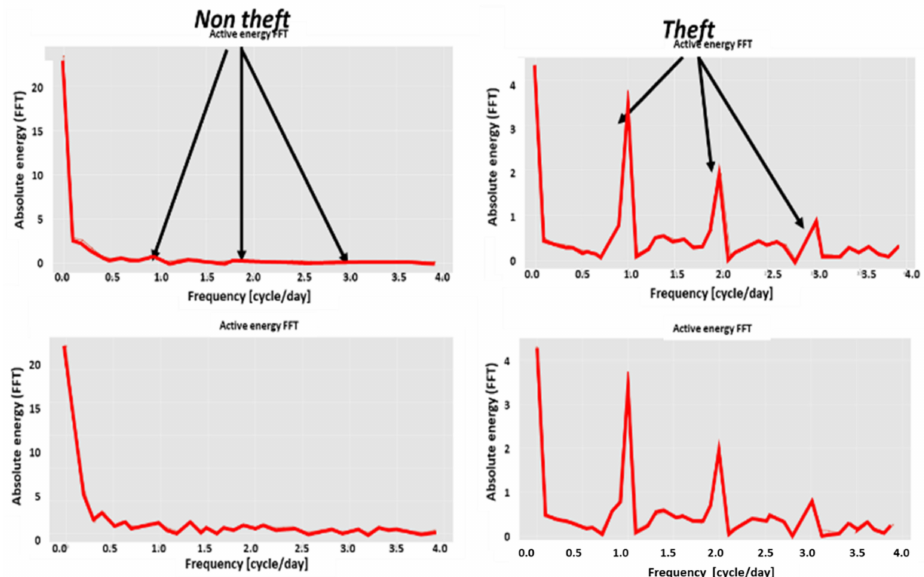
Figure 10. Characteristic non-fraud vs. validated fraud. Fraud—nontechnical and meter-reported failures. Non-fraud—other anomalies. Here, fraud is actual fraud. Technical loss type differentiation is